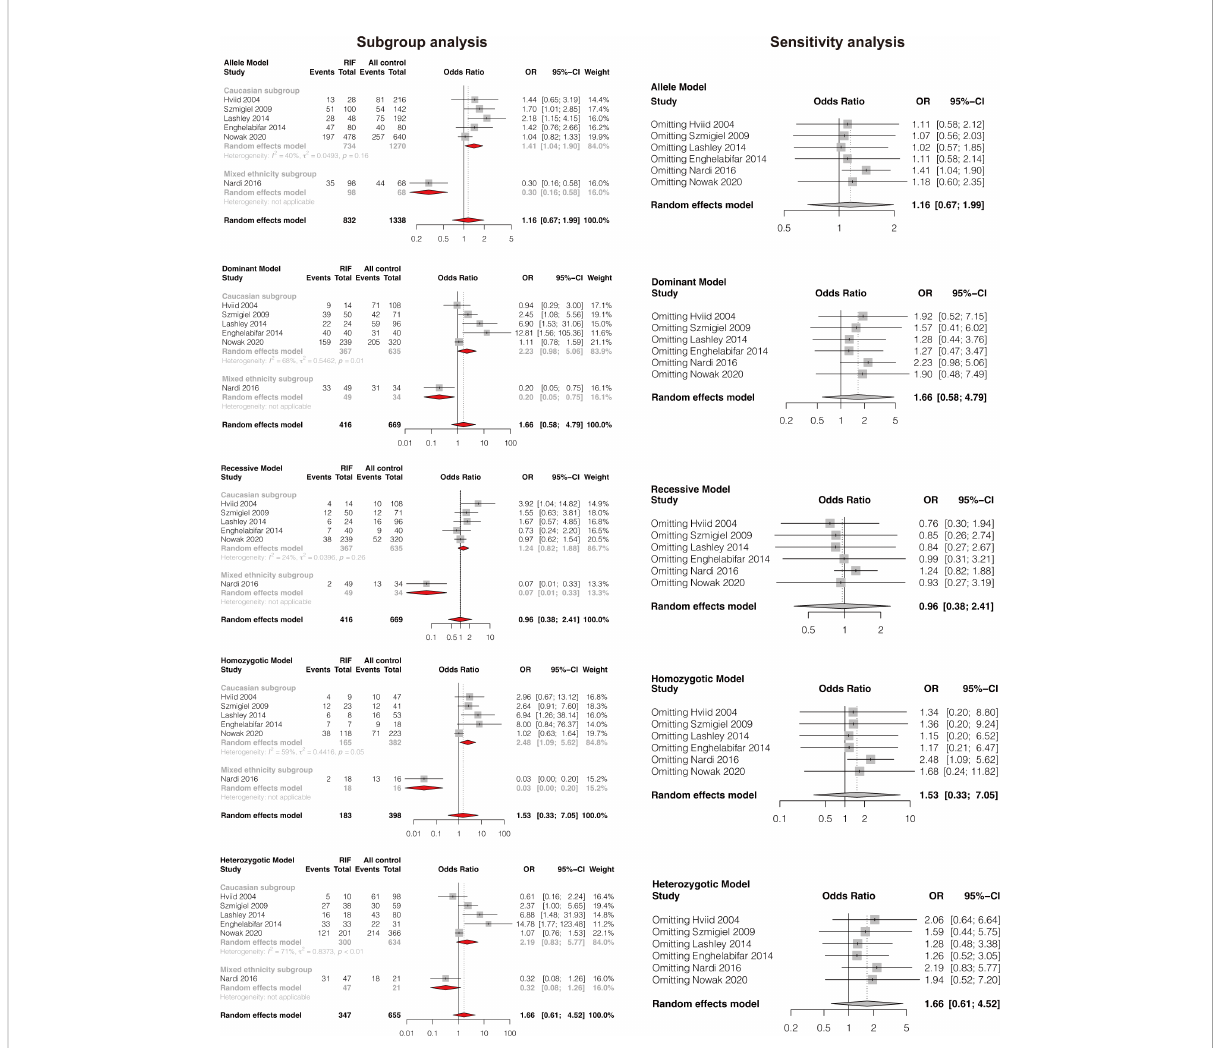
FIGURE 3 Forest plot showing subgroup analyses based on ethnicity and sensitivity analysis by omitting one study each